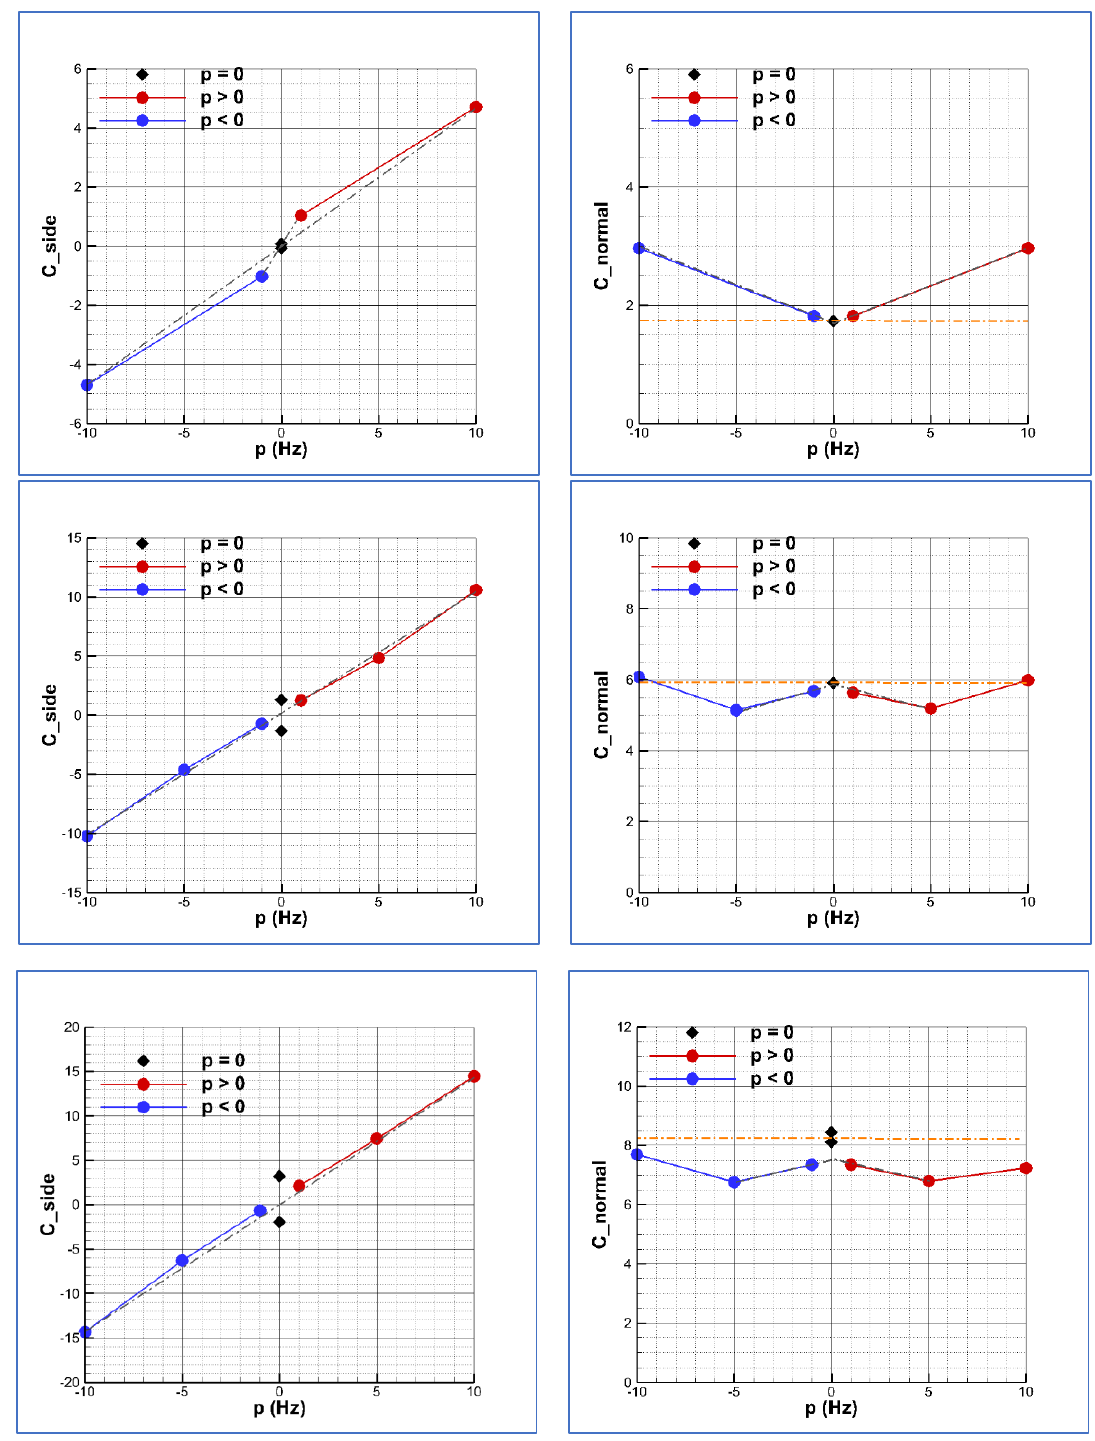
Figure 13 . Side ( left ) and normal ( right ) force coefficients vs. roll rate. Ma = 0.2, Re =2 × 10 6 . Calculations with α = 20 deg. ( above ), α = 35 deg. ( center ) and α = 45 deg. ( bottom ). Blue color: negative spin velocity. Red color: positive spin velocity. Black color: zero spin solutions. Extreme solutions of side force within a linear fit approach (grey line). Orange line: reference level for normal force (at zero spin).